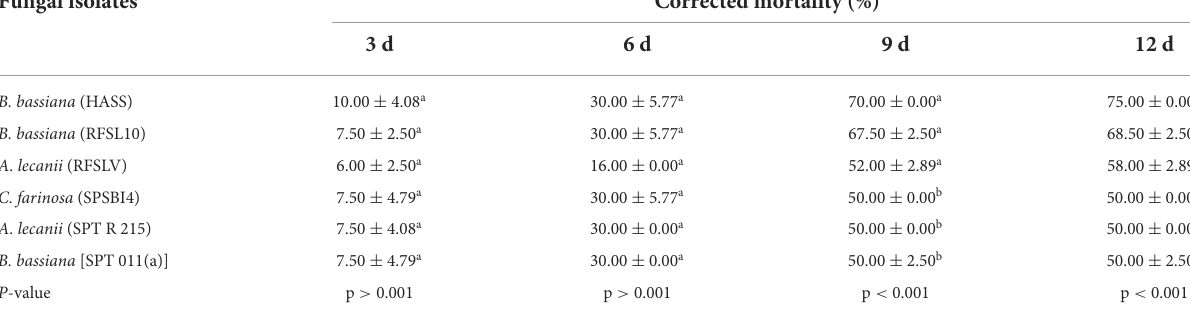
TABLE 5 Mean percentage of D. opuntiae nymphs mortality ± SE after exposure to six tested entomopathogenic fungi isolates at 10 8 conidia ml − 1 under greenhouse conditions.